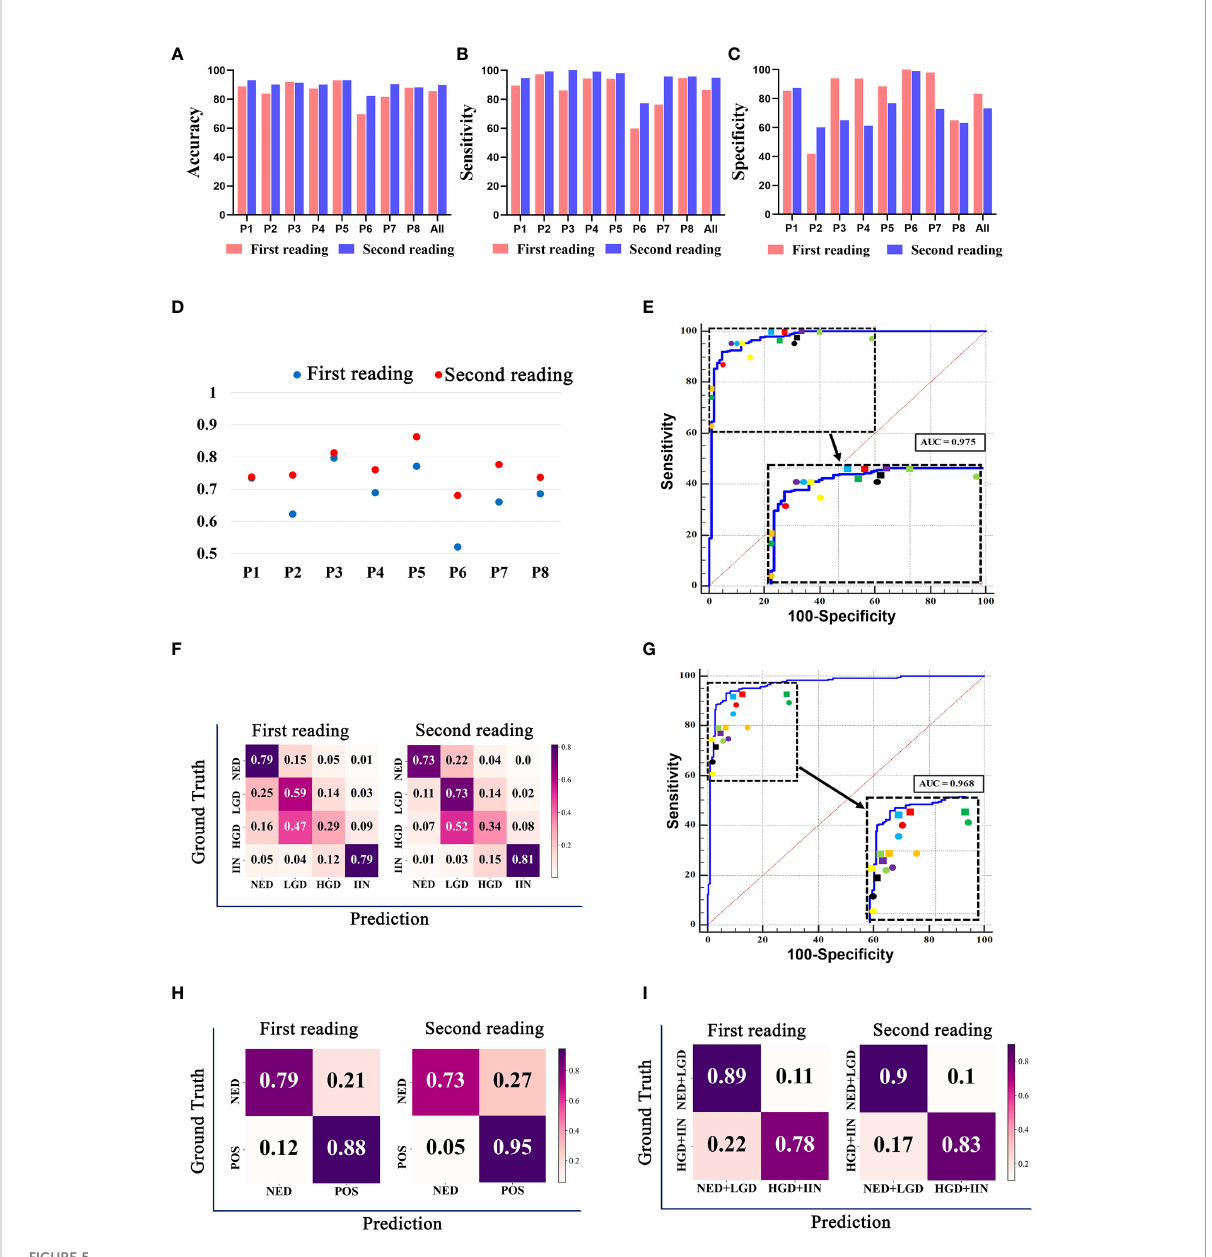
FIGURE 5 The classi fi cation results of pathologists with or without endoscopic gastric biopsy assistant system (EGBAS) assistance. (A-C) The accuracy, sensitivity and speci fi city of different categories for the fi rst reading (manual reading) and second reading (AI-assisted reading) in a two-tier classi fi cation (NED vs. LGD, HGD, and IIN). P1-P8 represent 8 pathologists. (D) Cohen ’ s k for each pathologist on four-tier classi fi cation. Each k value is the average pairwise k for each pathologist in two tests. (E) Results of a two-tier classi fi cation (NED vs. LGD, HGD, and